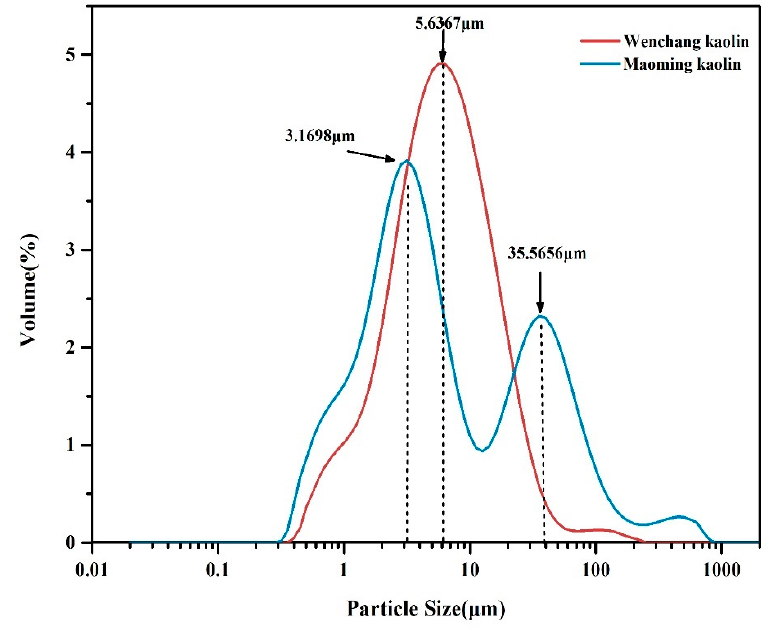
Figure 3. Particle size distribution of the two kaolins.